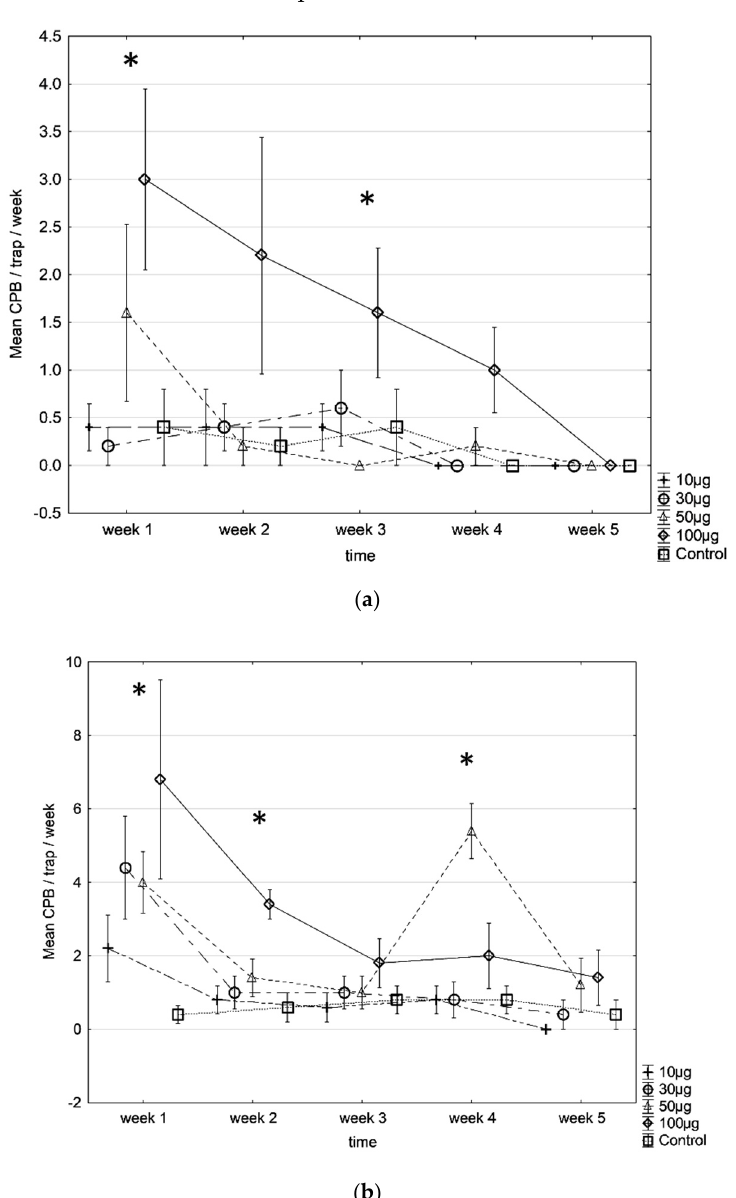
Figure 1. Mean captures of CPB ( ± SE) in traps baited with 10, 30, 50, and 100 μ g USDA pheromone lures against untreated blank-control traps for 4-weeks. Both comparative field trials were done at the Insitu farm during two different periods: ( a ) February 2019 ( Experiment #1, Test 1) and ( b ) October 2019 ( Experiment #1, Test 2). Each treatment was repeated five times in both field experiments. * p < 0.05. The efficacy of the pheromone lures loaded with various doses was tested for five weeks, as the significance with the unbaited blank control traps disappeared at week 5. Dur- ing the low population density season (Figure 1a), the trap baited with 100 µ g pheromone lure was the only one significantly capturing more CPB than the unbaited blank control trap after the first week of the experiment (F(4, 20) = 3.50, p = 0.025), then the average of captures decreased regularly. At week 5, there was no difference between any of the pheromone lures and the unbaited blank control